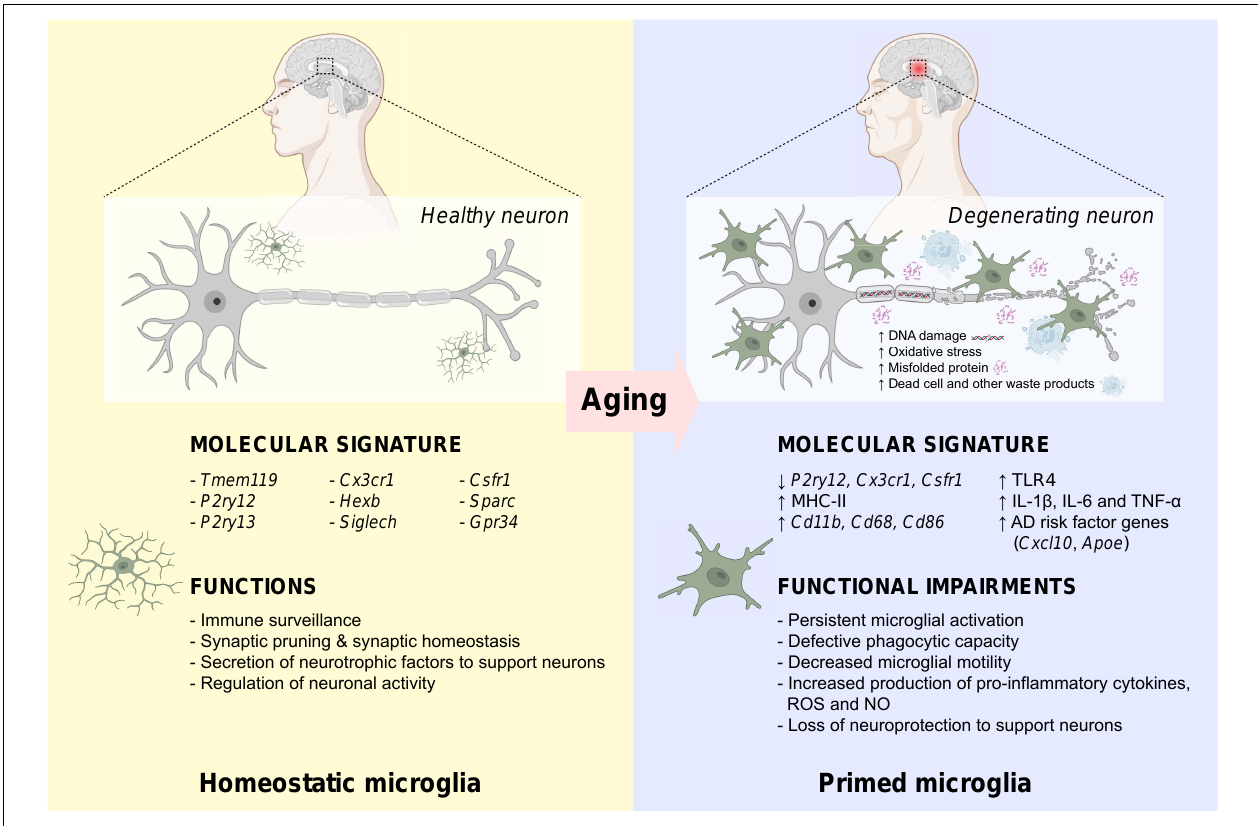
FIGURE 1 | Microglial priming during normal aging. In healthy individuals, microglia are active immune surveillant cells that expressed a wide variety of marker genes for homeostatic microglia. During normal aging, the increased DNA damage and oxidative stress, and the accumulation of misfolded proteins, dead cells and other waste products, induced activation of microglia leading to the down-regulation of homeostatic microglia marker gene expressions. Also, these activated “primed” microglia expressed high levels of major histocompatibility complex II (MHC-II), surface marker proteins (CD11b, CD68, and CD86) and various Toll-like receptors (TLRs). These primed microglia often displayed defective phagocytic capacity and decreased motility toward chemoattractants. The elevated production of neurotoxic pro-inflammatory cytokines lost their neuroprotection to support neurons. Publishing license from